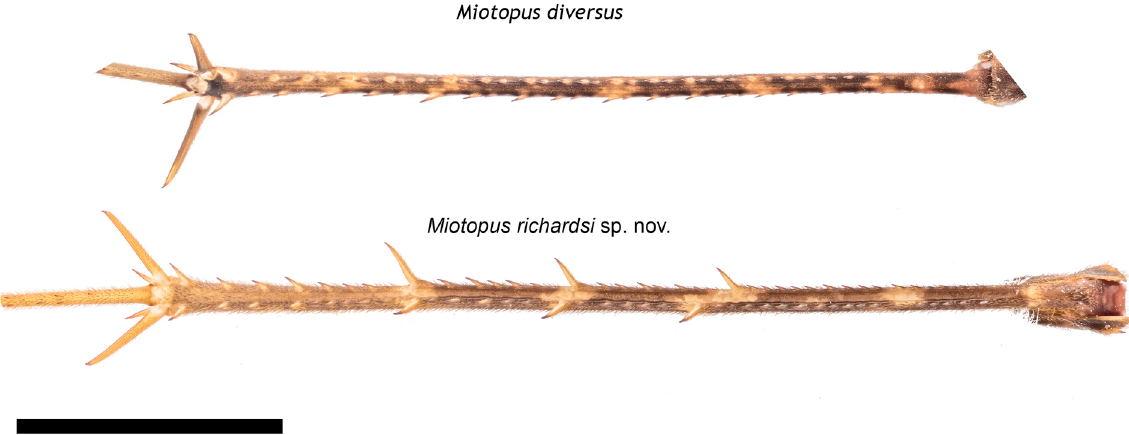
Fig. 9. Left hind tibia of cave wētā in the genus Miotopus hutton, 1898, dorsal view. Miotopus diversus (hutton, 1896) (MPN Cw3601) (top) and Miotopus richardsi sp. nov. (MPN Cw3543) (bottom). Scale bar = 5